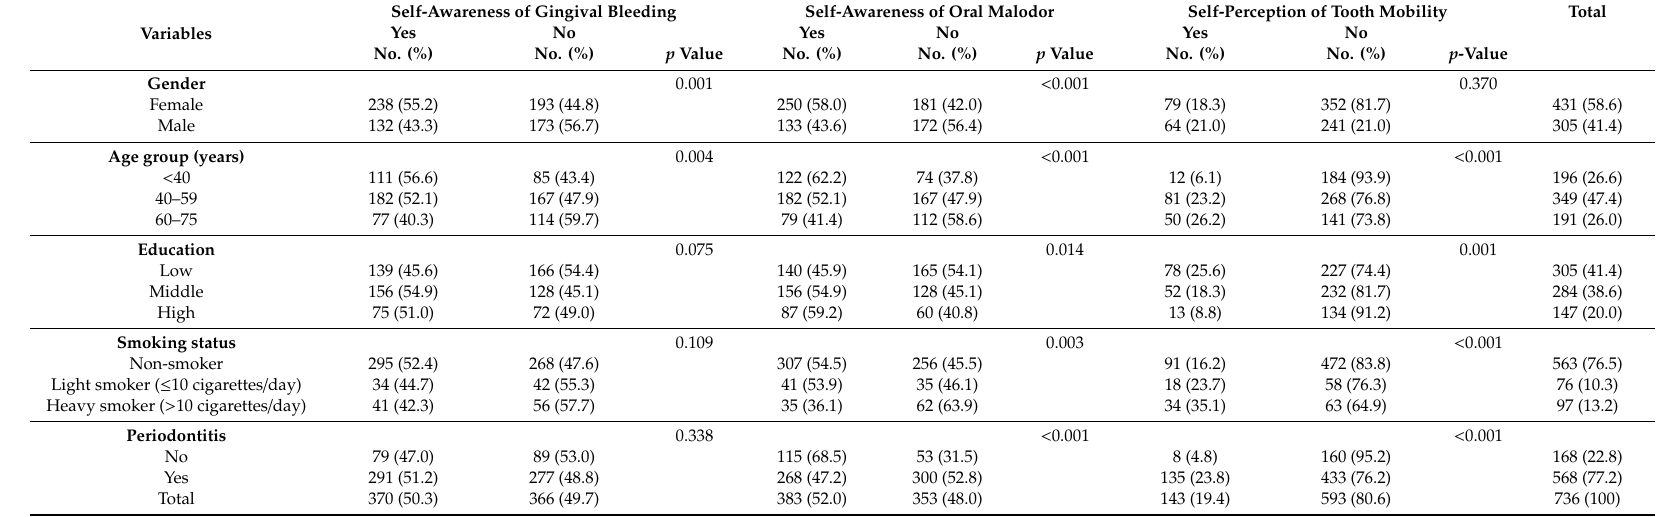
Table 2. Characteristics of subjects according to self-awareness of gingival bleeding and oral malodor and self-perception of tooth mobility.